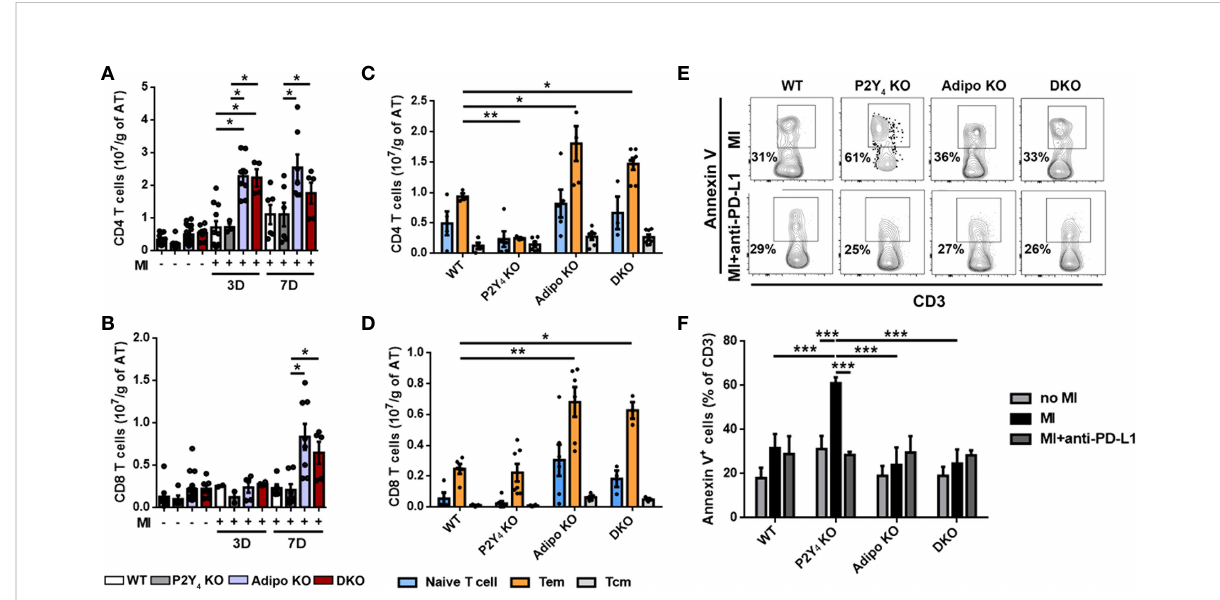
FIGURE 5 T cell apoptosis is increased in ischemic PAT of P2Y 4 KO mice. (A, B) Flow cytometry quanti fi cation of CD4 and CD8 T lymphocytes in PAT of WT, P2Y 4 KO, Adipo KO and DKO mice, 3 or 7 days (3D or 7D) post-MI, normalized to adipose tissue (AT) weight (g)). (C, D) Quanti fi cation of naive T cells, effector memory T cells (Tem) and central memory T cells (Tcm) by quanti fi cation of CD44 and CD62L in ischemic PAT, 7 days post-MI (n = 5-9). (E) Representative fl ow cytometry dotplots for annexin V + CD3 + lymphocytes in PAT WT, P2Y 4 KO, Adipo KO and DKO mice, 7 days post-MI. Mice were injected intraperitoneally or not, with anti-PD-L1 blocking antibody (10 µg/g) (PD-L1), 1h before LAD ligation then at days 1, 3 and 5 post-LAD ligation. (F) Flow cytometry quanti fi cation of annexin V + apoptotic T cells in PAT of WT, P2Y 4 KO, Adipo KO and DKO mice (percentage compared to total CD3 positive cells), 7 days post-MI mice or in sham mice (no MI). Ischemic mice were injected intraperitoneally or not, with anti-PD-L1 blocking antibody (10 µg/g), 1h before LAD ligation, then at days 1, 3 and 5 post-LAD ligation (n = 5-6). Data represent mean ± SEM. *p < 0.05; **p < 0.01; ***p <